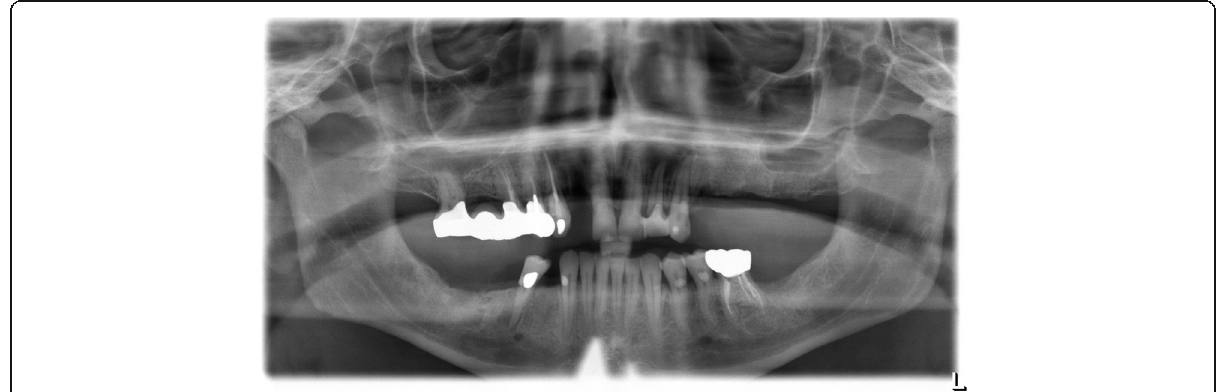
Fig. 2 Pre-operative panoramic radiograph